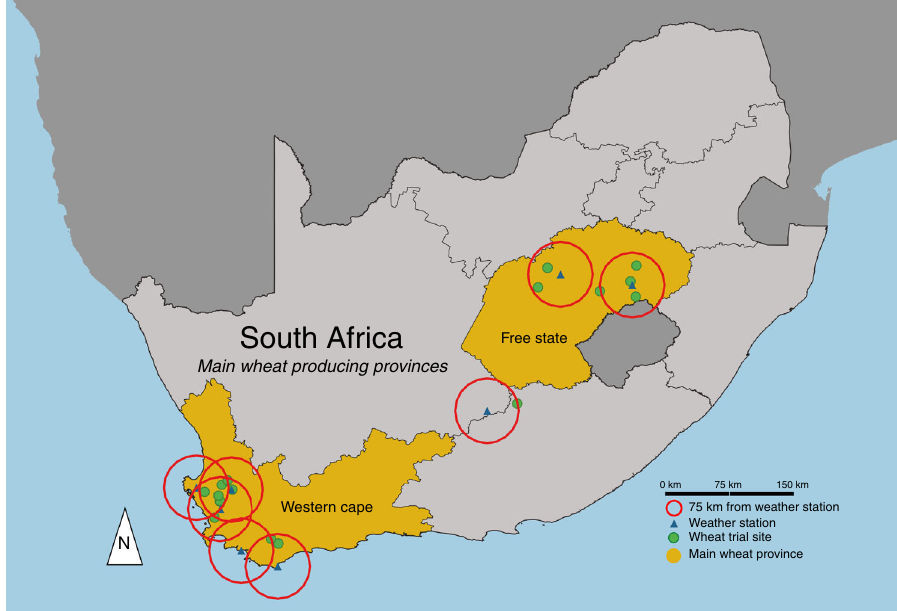
Fig. 1 Map of the wheat trial sites and weather station locations in South Africa. Free State and Western Cape provinces account for 73 and 99% of total and dryland wheat production, respectively, in South Africa 44 . Note, one wheat trial site and weather station is in the Eastern Cape Province, and the trial sites of Hope fi eld and Porterville appear as one location due to proximity. Created by A.M. Shew using QGIS 3.6.0-Noosa, under GNU General